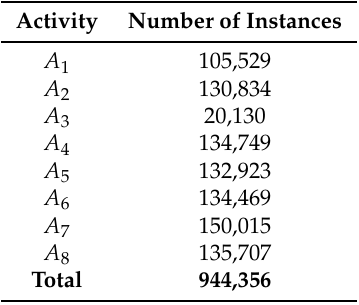
Table 3. Data distribution over the activities deduced from RealWorld HAR